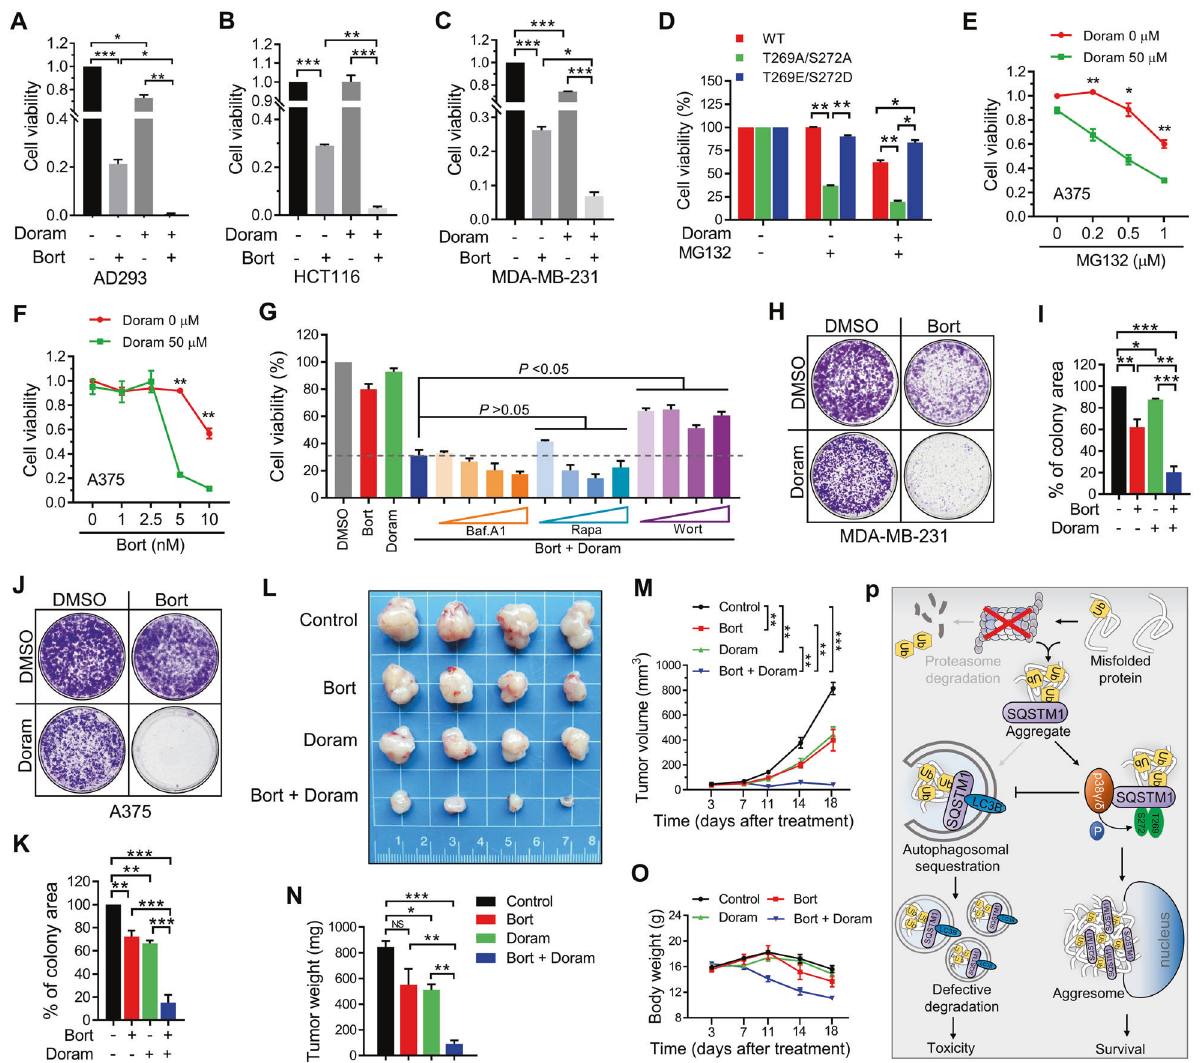
Fig. 8 Doramapimod aggravates proteasome inhibitor-induced cell death and tumor suppression. A AD293 cells were treated with DMSO (control), or Bortezomib (20 nM), and Doramapimod (50 μ M), alone or in combination for 36 h, and then examined the cell viability with CCK-8 assay. B HCT-116 cells were treated with DMSO (control), or Bortezomib (10 nM), and Doramapimod (50 μ M), alone or in combination for 24 h, and then examined the cell viability with CCK-8 assay. C MDA-MB-231 cells were treated with DMSO (control), or Bortezomib (10 nM), and Doramapimod (50 μ M), alone or in combination for 24 h, and then examined the cell viability with CCK-8 assay. D SQSTM1 knockout AD293 cells stably re-expressing FLAG-SQSTM1 (WT or mutants) were treated with DMSO (control), or MG132 (2 μ M), or MG132 (2 μ M)/Doramapimod (50 μ M) for 36 h, and then examined the cell viability with CCK-8 assay. E A375 cells were treated with MG132 at indicated concentrations with or without Doramapimod (50 μ M) for 24 h, and then examined the cell viability with CCK-8 assay. F A375 cells were treated with Bortezomib at indicated concentrations with or without Doramapimod (50 μ M) for 48 h, and then examined the cell viability with CCK-8 assay. G A375 cells were treated with indicated inhibitors (Bortezomib (20 nM), Doramapimod (50 μ M), Ba fi lomycin A1 (2, 5, 10, 20 nM), Rapamycin (0.2, 0.5, 1, 2 μ M), Wortmannin (0.2, 0.5, 1, 2 μ M)) for 24 h, and then examined the cell viability with CCK-8 assay. H , J MDA-MB-231 and A375 cells were treated with DMSO (control), or Bortezomib (5 nM), and Doramapimod (25 μ M), alone or in combination for 7 days, and then analyzed the cell colony-forming ability. I , K Quantitative analysis of results in ( H ) and ( J ). A – G , I , K Data are mean ± SEM of three independent experiments. * P < 0.05, ** P < 0.01, *** P < 0.001. L – O The anticancer effect of the combination of Bortezomib and Doramapimod in a A375 cell subcutaneous tumor model. L Excised tumors on day 18. M The tumor volume of each group was calculated two times every week. Data are mean ± SEM of four mice. ** P < 0.01, *** P < 0.001. N The tumor weights of excised tumors on day 18. Data are mean ± SEM of four mice. * P < 0.05, ** P < 0.01, *** P < 0.001, **** P < 0.0001, NS = not signi fi cant. O The body weight of each group was calculated two times every week. Data are mean ± SEM of four mice. P Model depicting proteasome inhibition-induced phosphorylation of SQSTM1 T269/S272 inhibits its autophagic receptor activity and promotes aggresome formation of misfolded